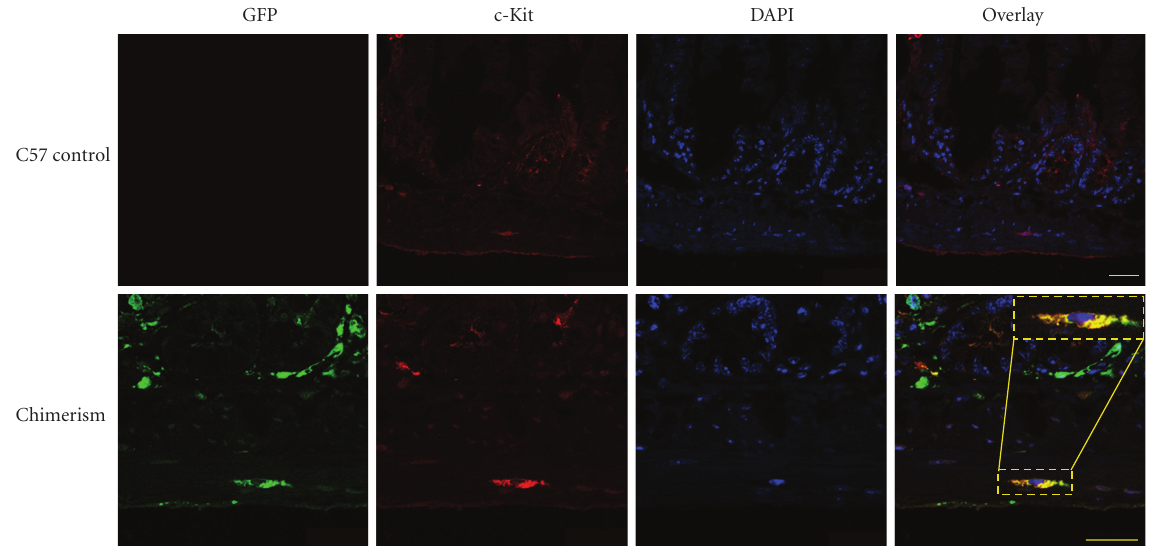
Figure 4: Confocal image of frozen section demonstrated donor derived ICCs-MY in small intestine of recipient mice 2.5 months after bone marrow transplantation. Upper panel: C57 mouse was used as negative control, in which there were no GFP signals in the intestine. Lower panel: In the chimerism, GFP and c-Kit double positive cells were shown in the merged image. Amplified image of interested cell was shown as inset. Bar = 25 μ